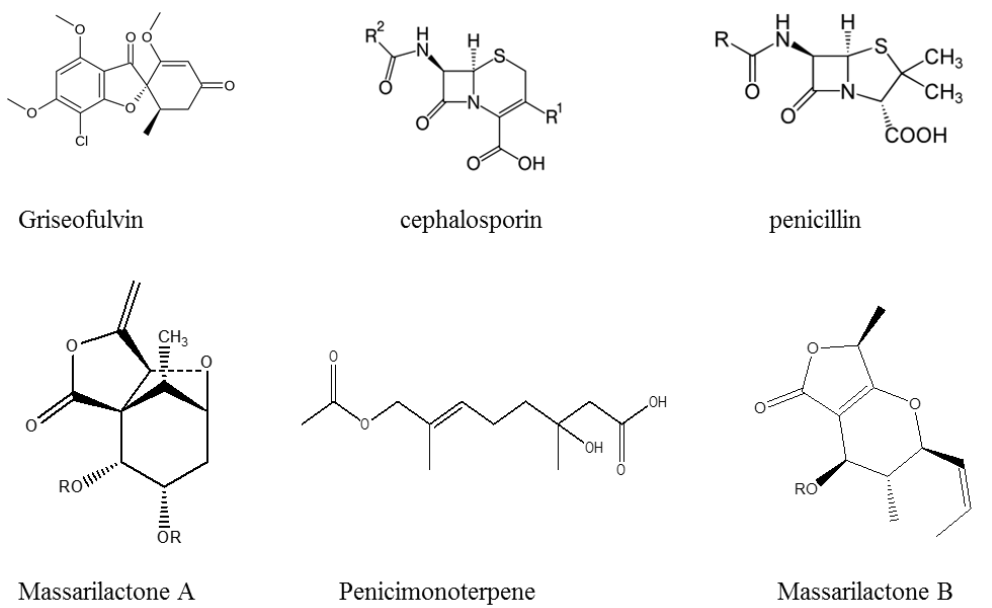
Figure 2. Beneficial metabolites from aquatic fungal species.